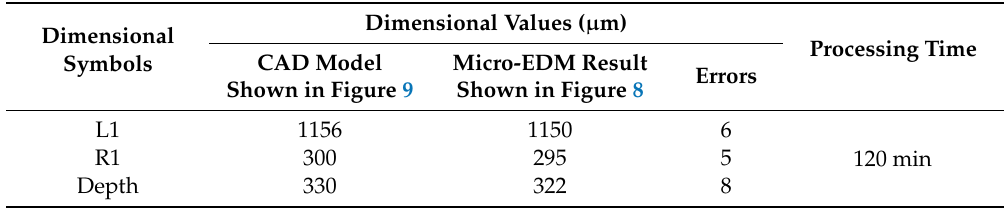
Table 1. Dimensional comparison between computer-aided design (CAD) model shown in Figure 9 and micro electrical discharge machining (micro-EDM) result shown in Figure 8.